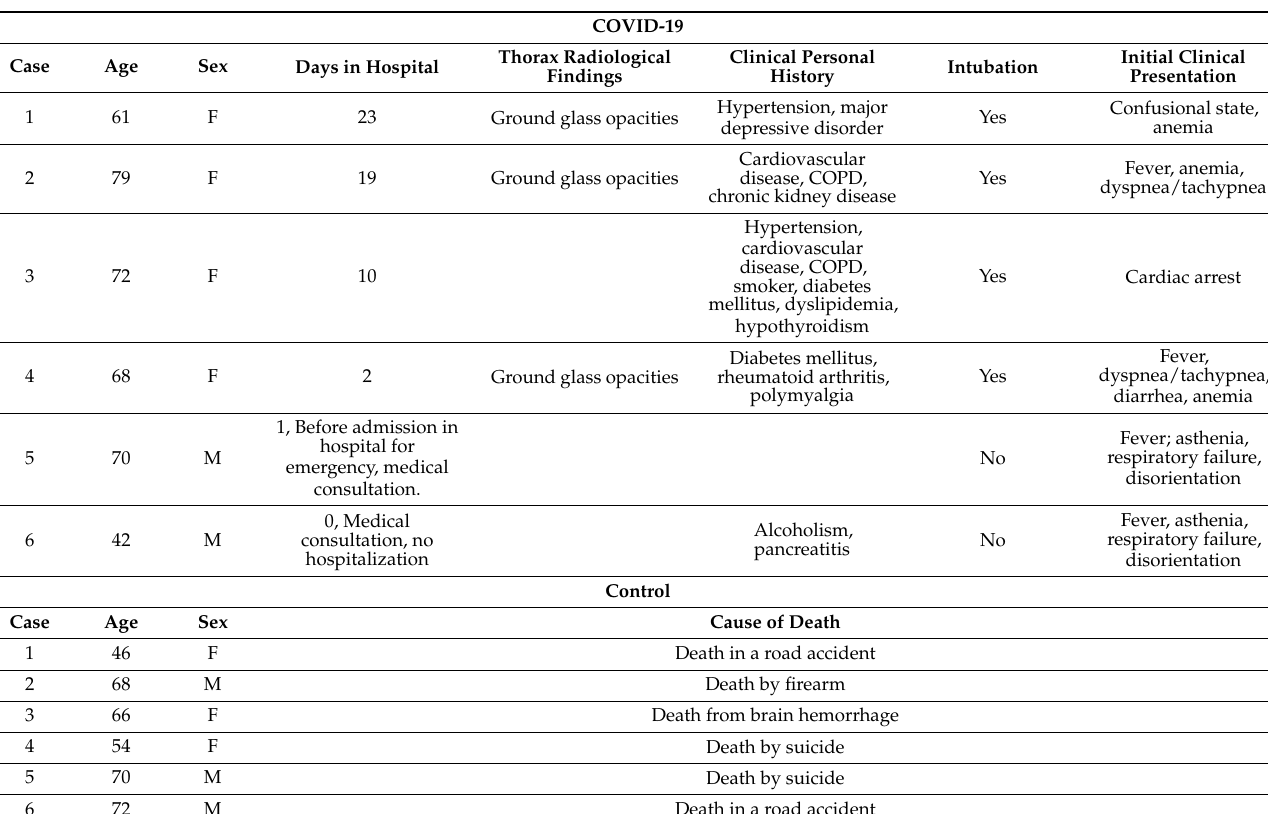
Table 1. Summary of clinical information of